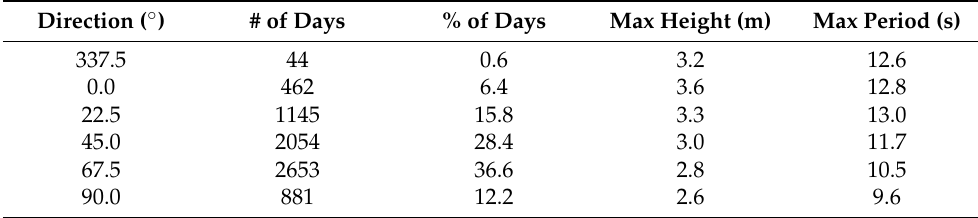
Figure 6. ( a ) Number of days by month over the 40-year study period for swells from different directions. Daily maximum swell ( b ) height and ( c ) period, spatially averaged over the eastern Caribbean study area by month and swell direction. Direction labels represent the center point of each 22.5 ◦ bin. Directions from 112.5 ◦ to 315.0 ◦ are not shown and have swell counts of zero except for the following month/direction pairs: Nov/112.5 ◦ = 1, Nov/270.0 ◦ = 1, Nov/292.5 ◦ = 2, Jan/112.5 ◦ = 1, Jan/315.0 ◦ = 1, Feb/112.5 ◦ = 1, Mar/112.5 ◦ = 1, and Apr/112.5 ◦ = 3. Table 1. Total number and percentage of days, and average maximum swell height and period for those days, binned by direction based on the monthly data shown in Figure 6.